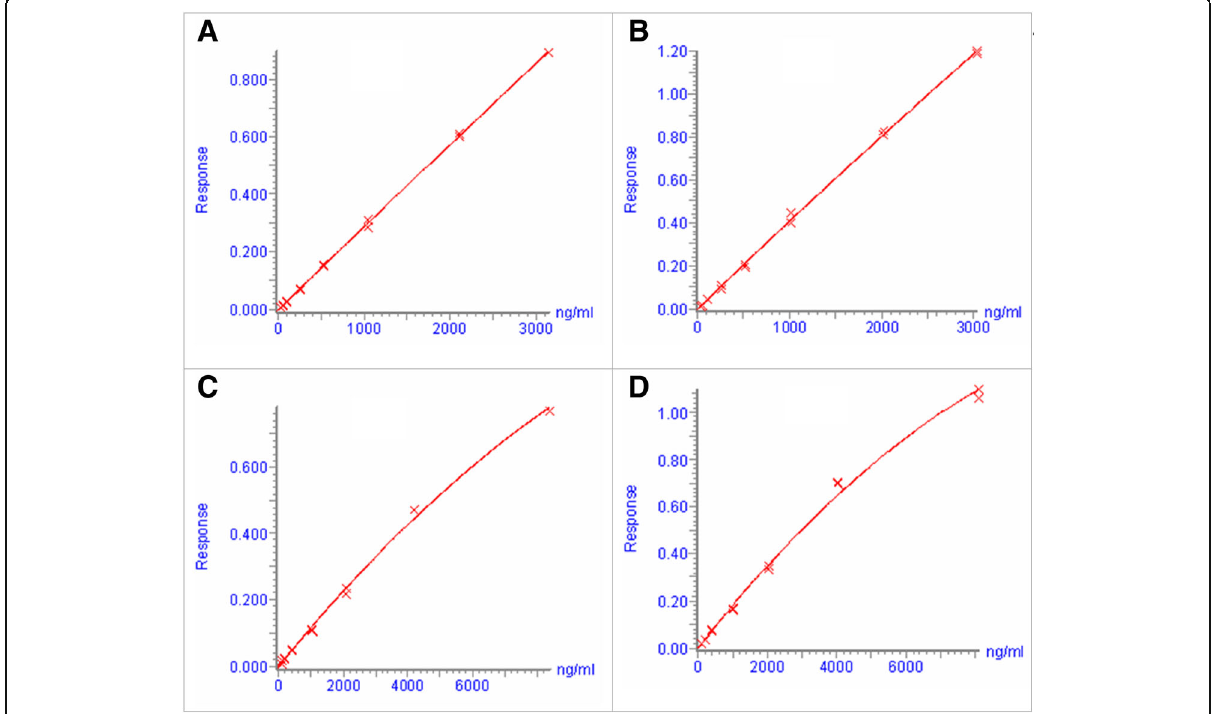
Fig. 3 Calibration curves for Qu ( a, c ) and Ir ( b, d ) in plasma ( a, b ) and urine ( c, d )